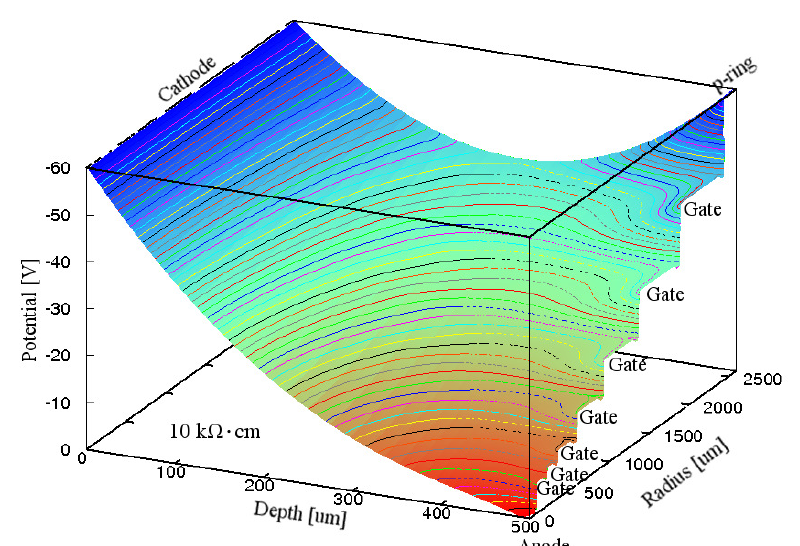
Figure 2. Simulated electric potential distribution in the Si substrate inside the p-ring of a 0 . 5 -mm-thick GSDD with R of 3 . 5 mm and ρ of 10 k Ω · cm for Gate A. A reverse bias chip Si voltage of − 60 V was applied to the cathode, p-ring, and seven gates. Q was assumed to be F 3 × 10 10 cm − 2 . Equipotential lines are shown at 1 V